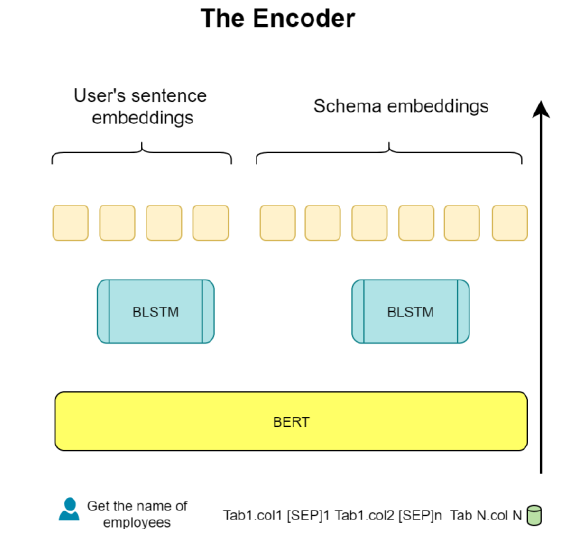
Figure 1. The general structure of an